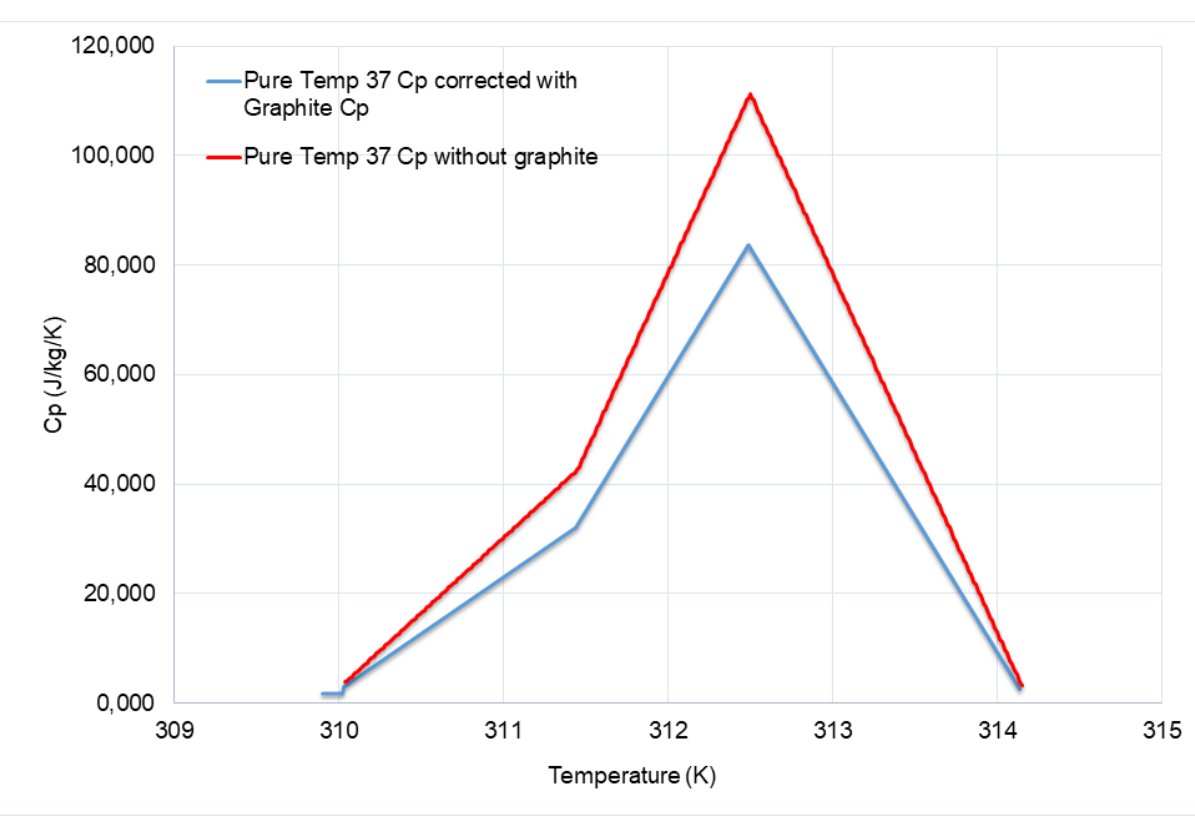
Table 3. HSS specifications for different discharge rates.